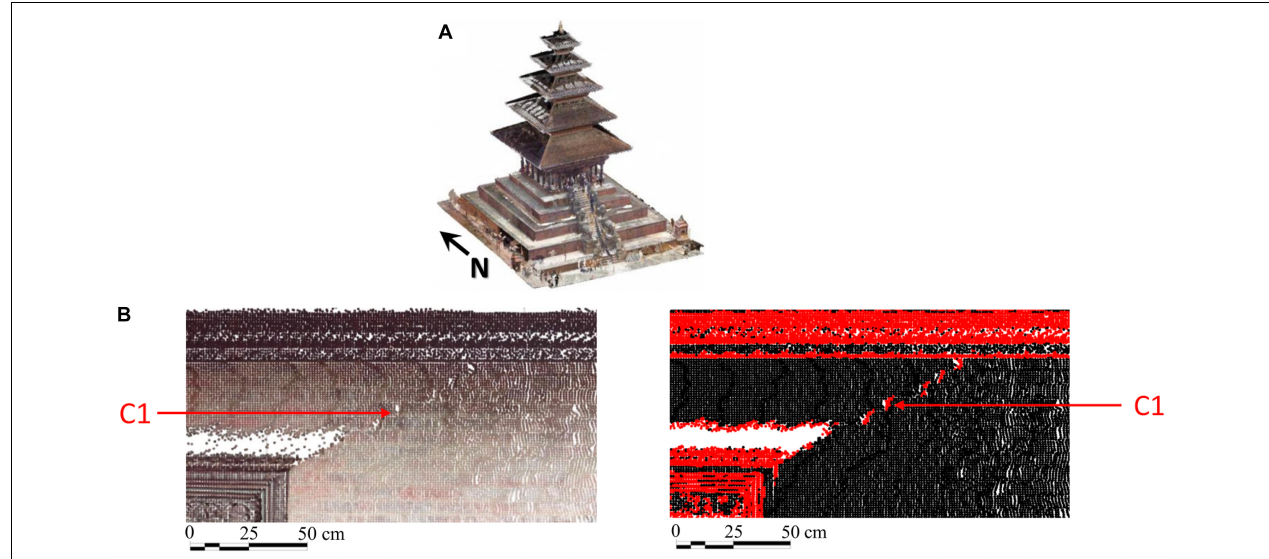
FIGURE 2 | Assessing the performance of buildings using lidar data collected during reconnaissance. (A) Lidar-derived 3D model of Nyatapola Temple following the 2015 Ghorka Nepal Earthquake (B) Earthquake-induced crack (designated as “C1”) seen in a color point cloud (left) and detected defects shown in red (right). Reproduced from Wood P. R. et al. (2017).